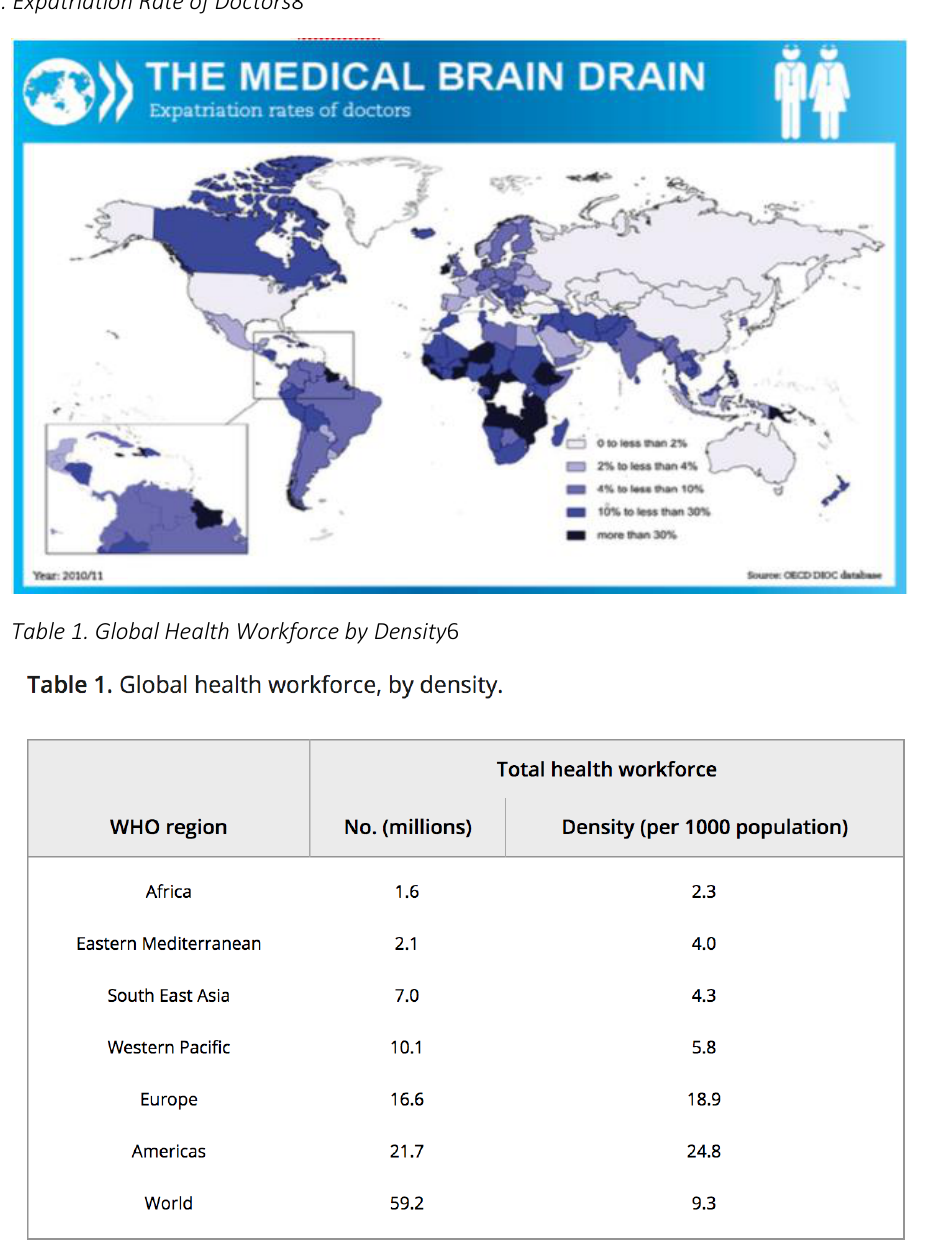
Figure 1. Expatriation Rate of Doctors 8